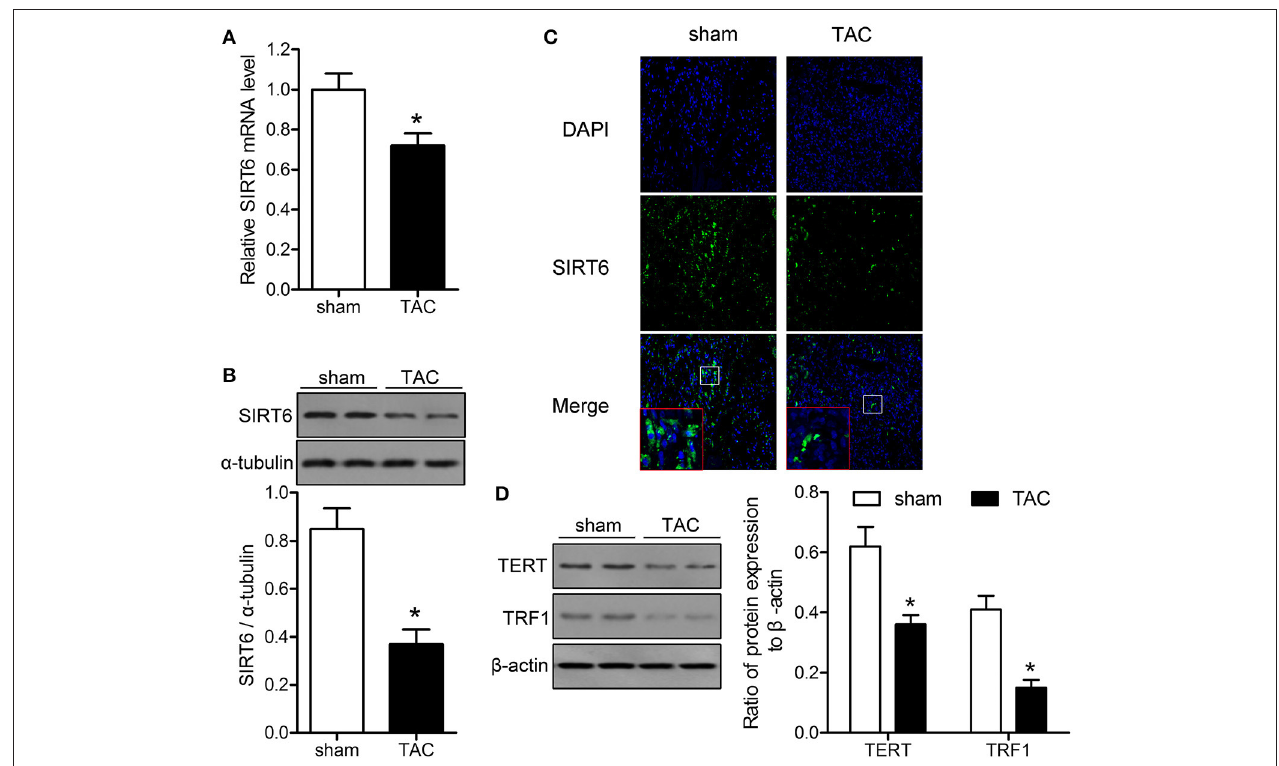
FIGURE 1 | SIRT6 and telomerase associated proteins are downregulated in the myocardium of transverse aortic constriction (TAC) mice. TAC or sham surgery was performed in mice, and myocardial tissue samples were collected at 28 days after surgery. (A) SIRT6 mRNA expression in myocardial tissues was determined by qRT-PCR and normalized to GAPDH expression. * P < 0.05 vs. sham group. (B) Western blot assessment of the expression levels of SIRT6 normalized to α -tubulin expression level. * P < 0.05 vs. sham group. (C) Immunofluorescence labeling of SIRT6 (green) in myocardial tissues, nuclei were stained with DAPI (blue). 200 × magnification. (D) Western blot assessment of the expression levels of telomere reverse transcriptase (TERT), and telomere repeat binding factor (TRF)1 normalized to β -actin expression levels. * P < 0.05 vs. sham group. n = 5 in the sham group, and n = 8 in the TAC